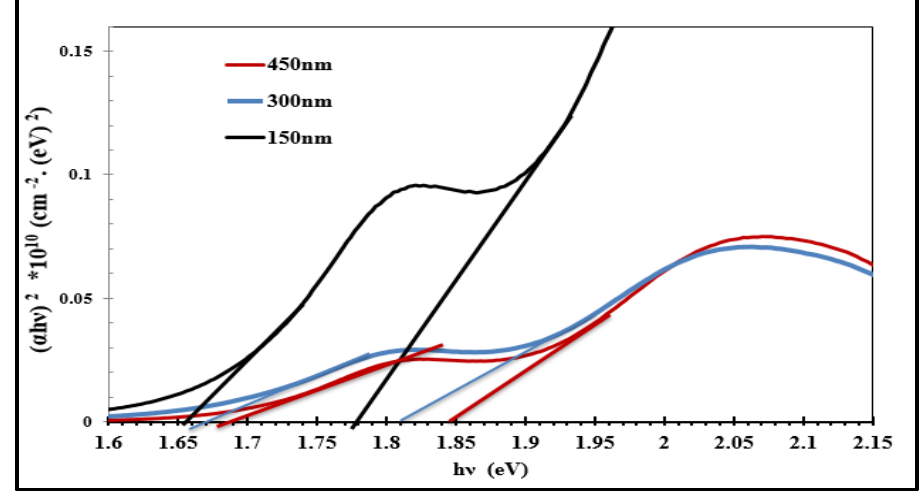
Fig.6: Graph shows (αhʋ) 2 vs. the energy of the photon for CuPc at different thicknesses at Q-band.